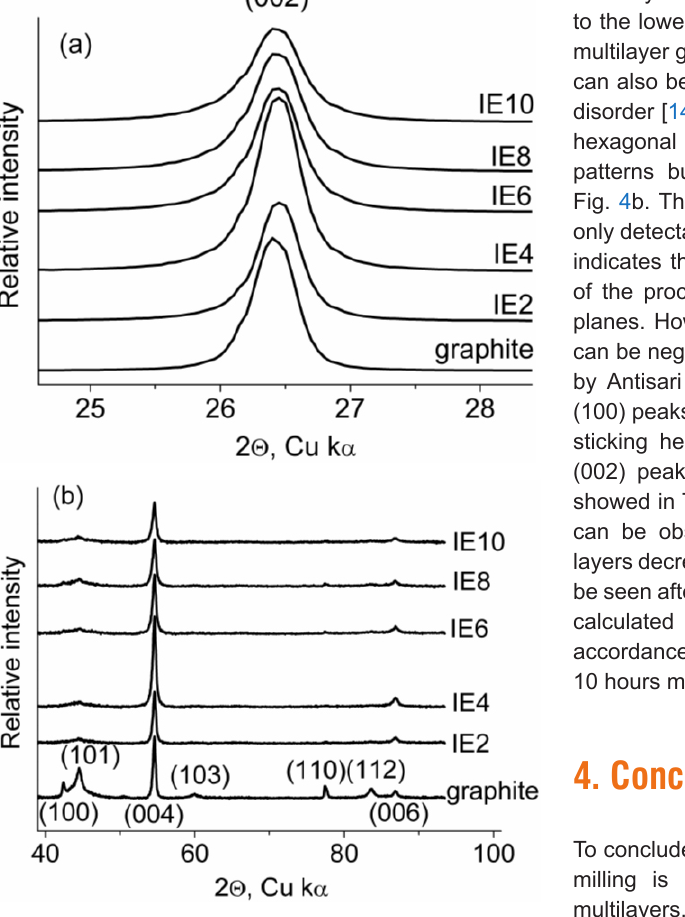
Figure 4. (a-b) XRD patterns of graphite milled intensively in ethanol for 10 h: starting material (synthetic graphite), IE2 –